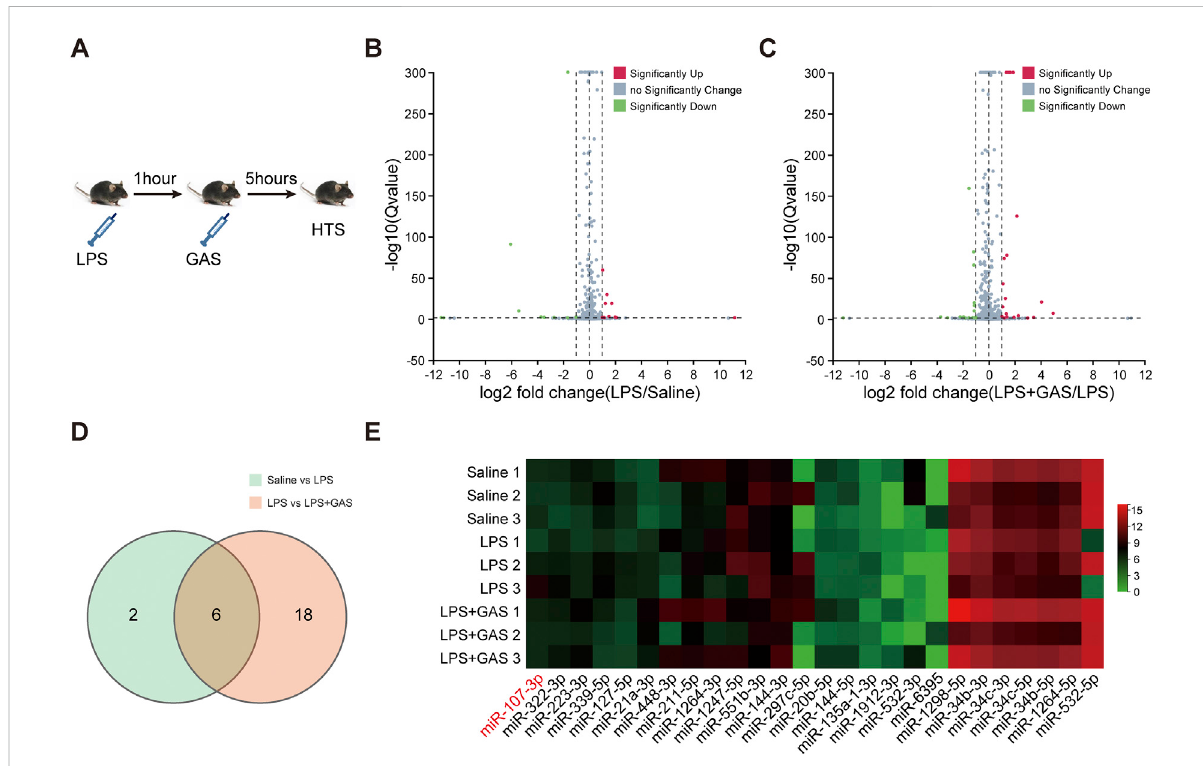
FIGURE 3 Differential miRNAs pro fi le associated with GAS on LPS induced-neuroin fl ammation. (A) Experimental fl ow chart of high-throughput sequencing. (B,C) Volcano plot based on differently expressed miRNAs ( n = 3). (D) Venn diagram of cluster analysis of signi fi cantly differentially expressed miRNAs. (E) Cluster analysis heat map of differentially expressed miRNAs. LPS, lipopolysaccharide; GAS,